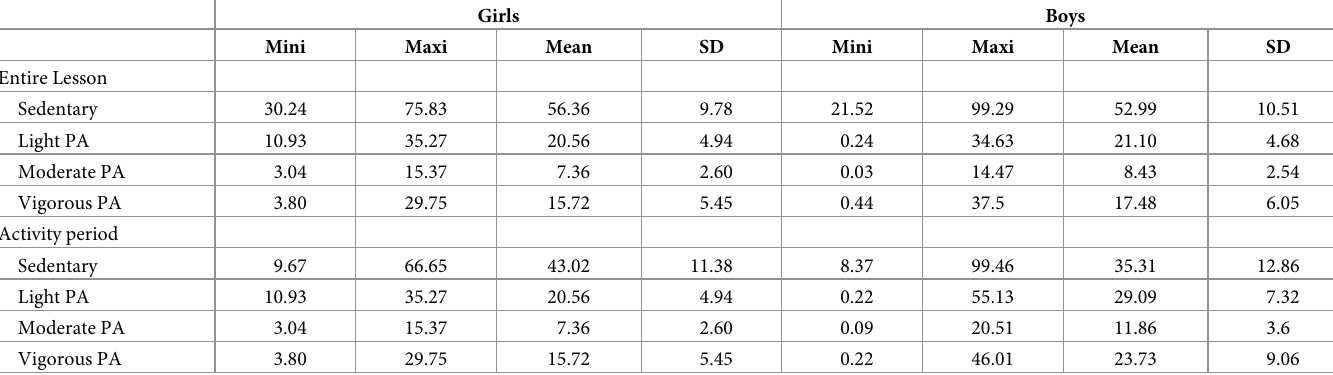
Table 1. Descriptive statistics (percentage of the time) for PA-related behaviors during the entire lesson and the